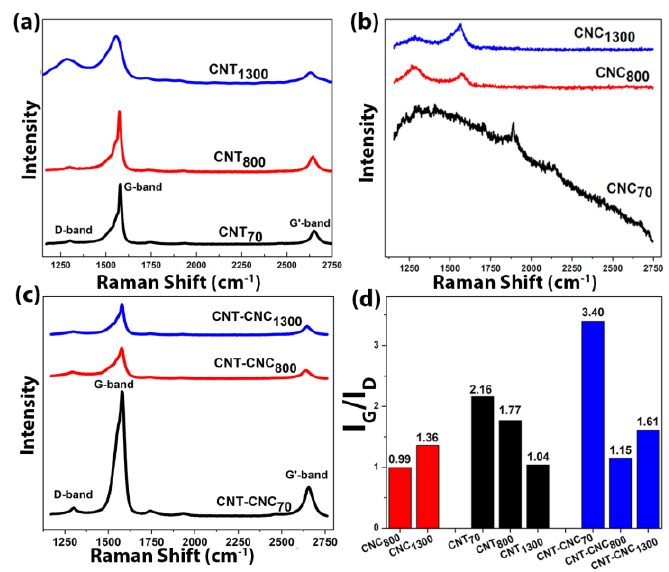
Figure 4. Raman spectra of ( a ) CNT at 70 °C, 800 °C, and 1300 °C, ( b ) CNC at 70 °C, 800 °C, and 1300 and ( c ) CNT–CNCs at 70 ◦ C, 800 ◦ C, and 1300 ◦ C. ( d ) Comparison of I G / I D ratio with various samples. °C, and ( c ) CNT – CNCs at 70 °C, 800 °C, and 1300 °C. ( d ) Comparison of I G /I D ratio with various samples.